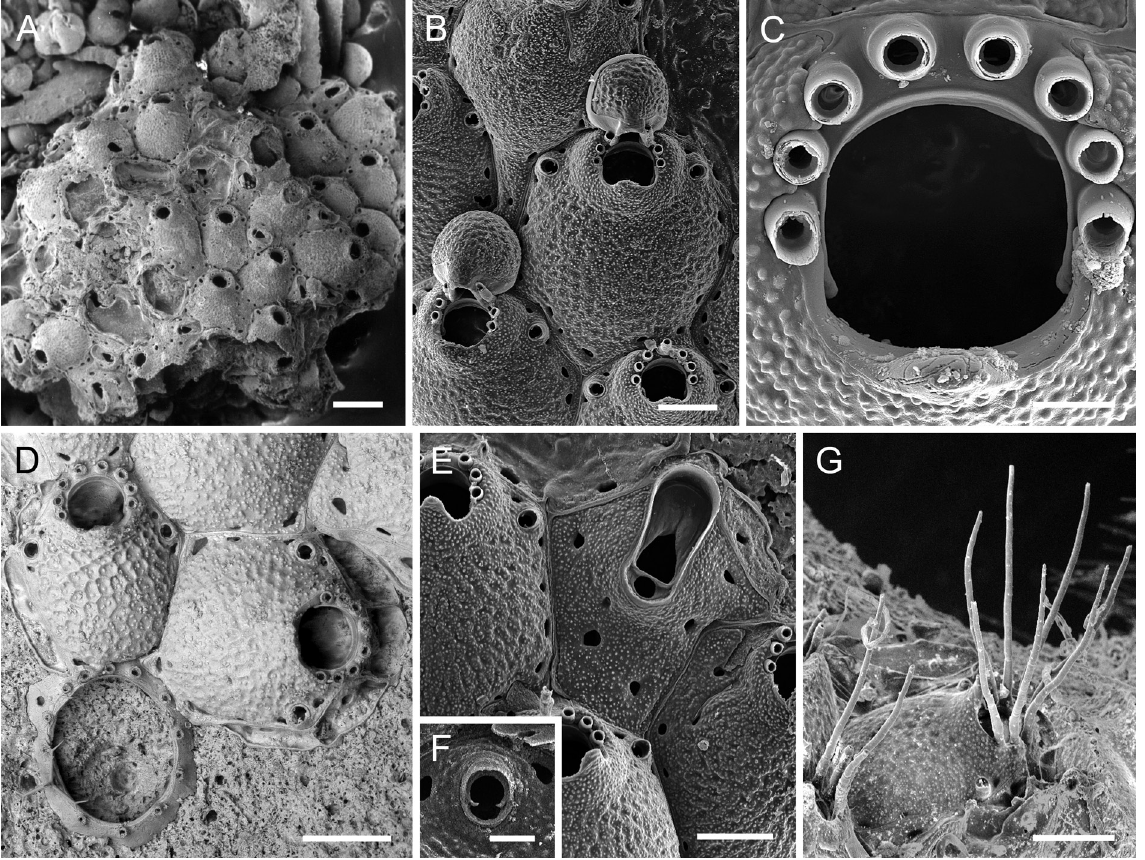
Fig. 12. Baythycyclopora suroiti gen. et sp. nov., Atlantis Smt. A . Overview of a partly damaged colony (paratype, OLL 2016/149). B . Ovicellate zooids (paratype, MNHN-IB-2014-77). C . Close-up of an orifice (paratype, MNHN-IB-2014-77). D . Ancestrula and the first two autozooids (paratype, OLL 2016/126). E . Interzooidal avicularium; note the single communication pore per neighbouring zooid as well as the extensive cryptocystal calcification surrounding it and the thin peripheral band of gymnocyst (paratype, MNHN-IB-2014-77). F . Close-up of adventitious avicularium (paratype, MNHN- IB-2014-77). G . Lateral view of oral spines (holotype, MNHN-IB-2014-73). Scale bars: A = 500 µm; B, D–E, G = 200 µm; C, F = 50